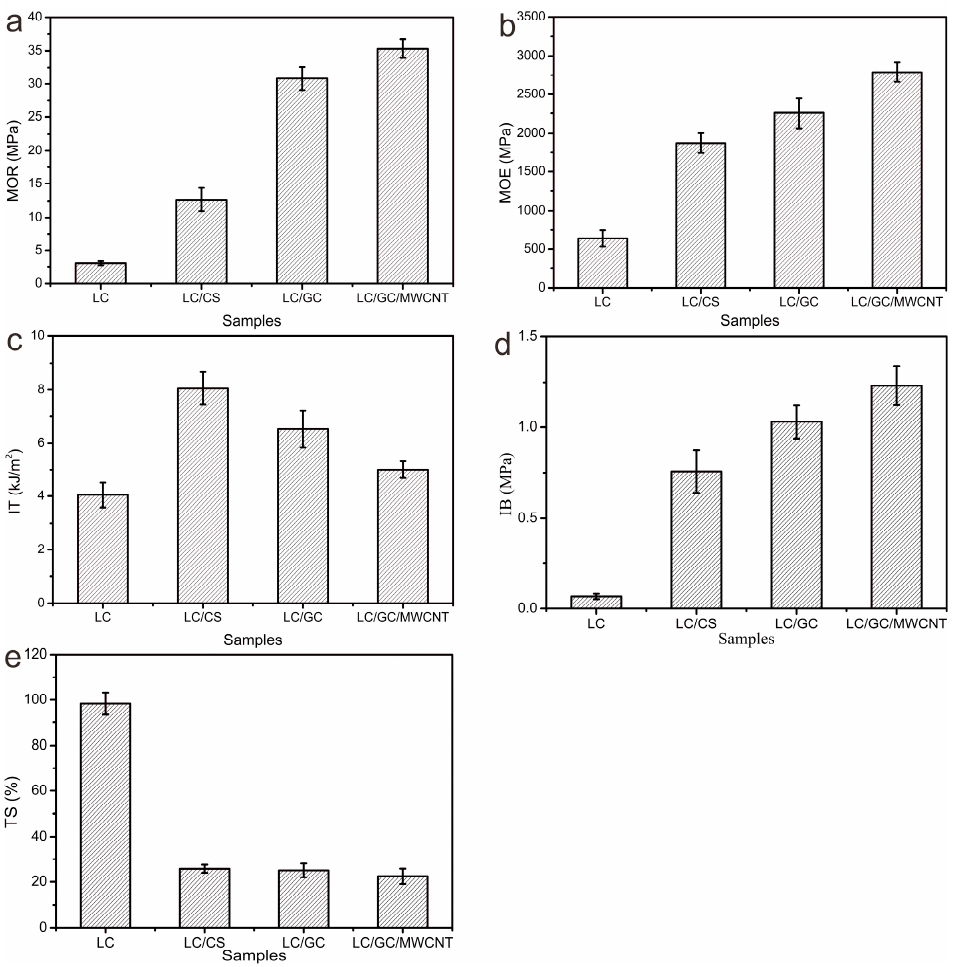
Figure 7. Physical and mechanical properties of LC composite, LC/CS composite, LC/GC composite, LC/GC/MWCNT composite: ( a ) MOR ( b ) MOE ( c ) IT ( d ) IB ( e ) TS values.